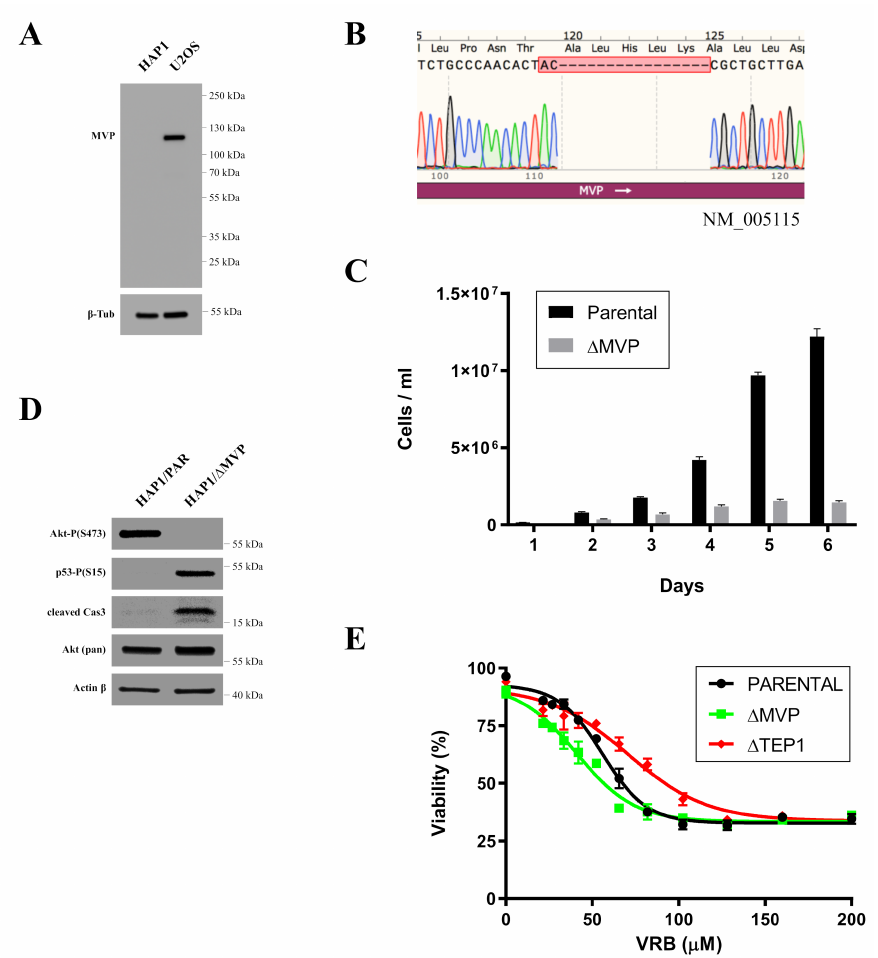
Figure 2. Analysis of MVP-negative HAP1 cells. ( A ) Comparison of endogenous MVP expression in HAP1 and U2OS cells. ( B ) Sequence analysis within the MVP gene in MVP-negative (HAP1- ∆ MVP) cells. ( C ) Assessment of the growth of HAP1 and HAP1- ∆ MVP parental cells. ( D ) Analysis of proteins related to the processes of proliferation and apoptosis. ( E ) Survival curve of HAP parental cells and MVP- and TEP1-negative cells in the presence of vinorelbine